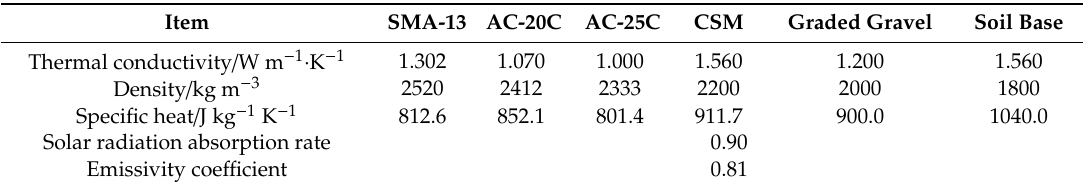
Figure 7. Ordinary asphalt pavement structure in China: ( a ) Asphalt pavement structure; ( b ) 2D FE model. Table 5. Thermal parameters.